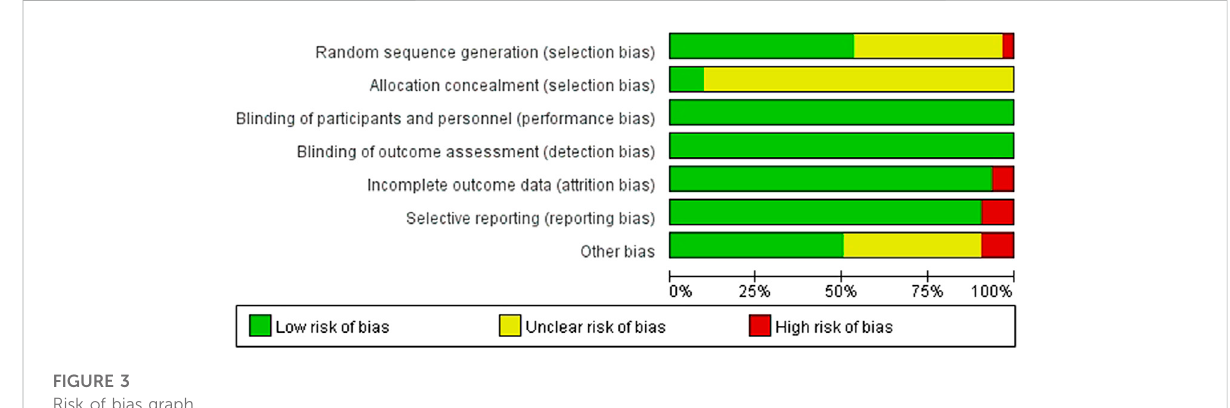
FIGURE 3 Risk of bias